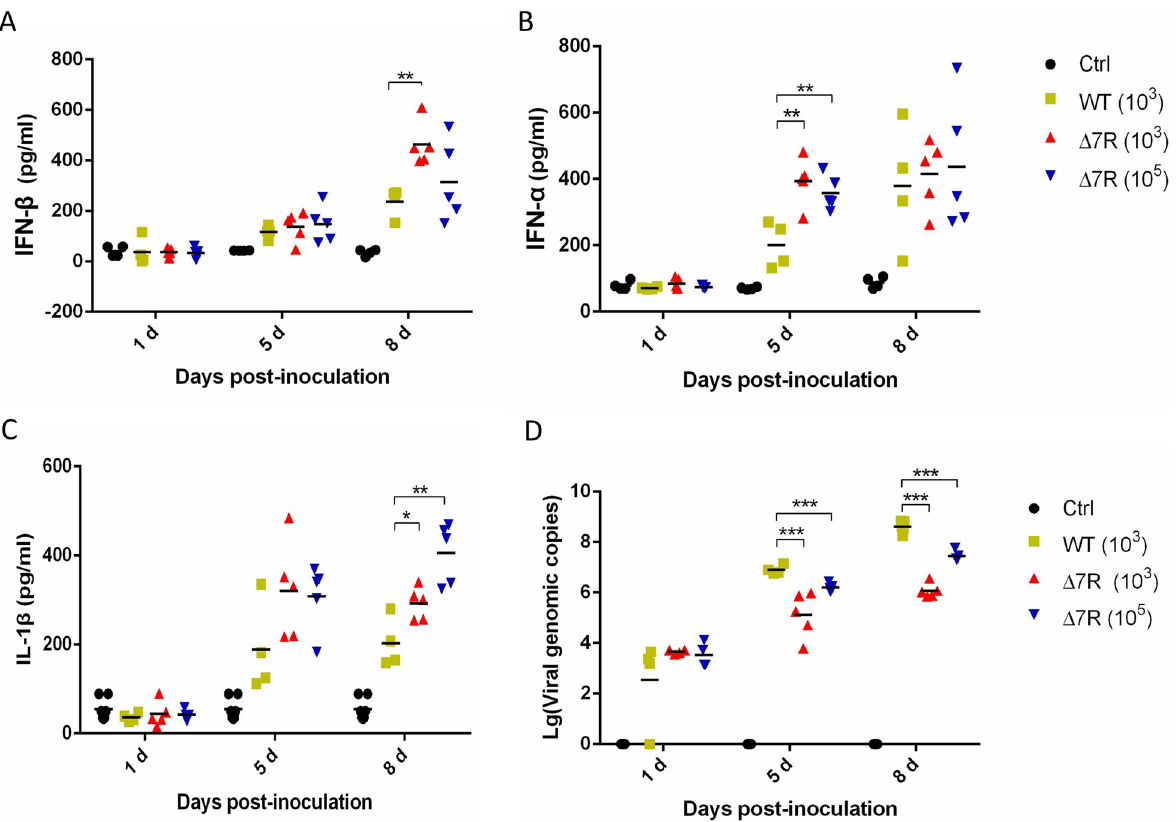
Fig 10. ASFV- Δ 7R infection induces higher type I IFN and IL-1 β production in pigs. (A-D) Pigs were mock challenged with PBS (Ctrl, n = 4) or challenged intramuscularly with ASFV- Δ 7R ( Δ 7R, n = 5, 10 3 and 10 5 HAD 50 ) or parental ASFV-WT (WT, n = 4, 10 3 HAD 50 ), and the sera samples were collected at day 1, day 5 and day 8 post challenge. The protein levels of IFN- β (A) , IFN- α (B) and IL-1 β (C) in the serum samples were measured with commercial ELISA kits. The virus loads in the serum samples collected at day 1, day 5 and day 8 post challenge. were evaluated using qPCR. (D) Data presented are mean ± SD. �� , P < 0.01, � , P < 0.05, student’s t-test , in comparison with control groups during statistical